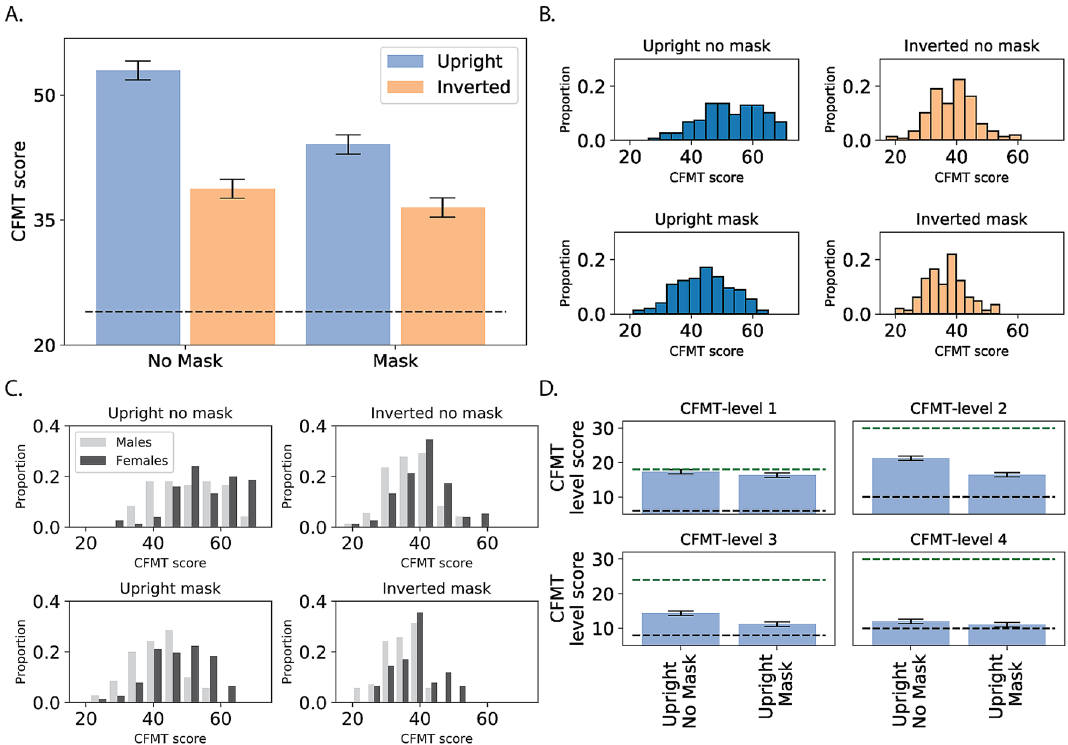
Figure 2. Results of Experiment 1: ( A ) Results of the CFMT experiment for non-masked and masked and faces. The dashed black horizontal line represents chance level (also in panel D ). Performance was significantly impaired for masked faces. An inversion effect was found for masked and for non-masked faces, but it was significantly reduced for masked faces. For all figures, error bars represent the 95% confidence interval for the main effect of group (mask/no mask). ( B ) Distribution of CFMT results across the different conditions. ( C ) Distribution of the CFMT results across the different conditions separately for female and male participants. Females performed better than males across all conditions. ( D ) Analysis of the separate phases of the CFMT. An advantage for non-masked faces was found across all levels, including level 4, in which overall performance was close to chance level. The green dashed horizontal line represents the maximal